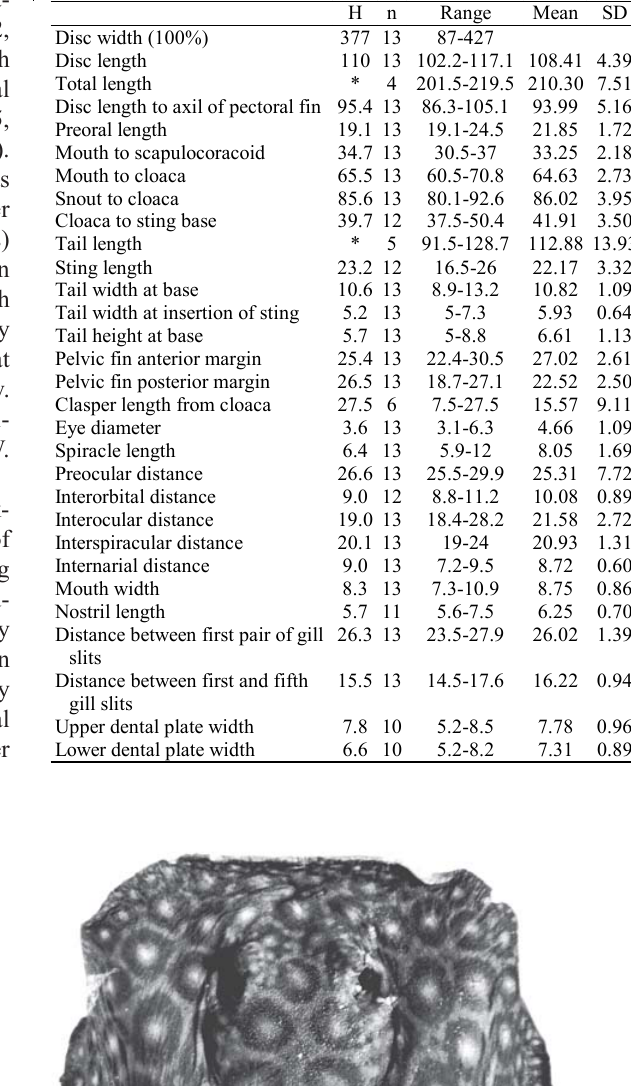
Table 1. Proportional measurements on specimens of Potamotrygon boesemani , as percent of disc width. Aster- isks indicate the broken tail of the